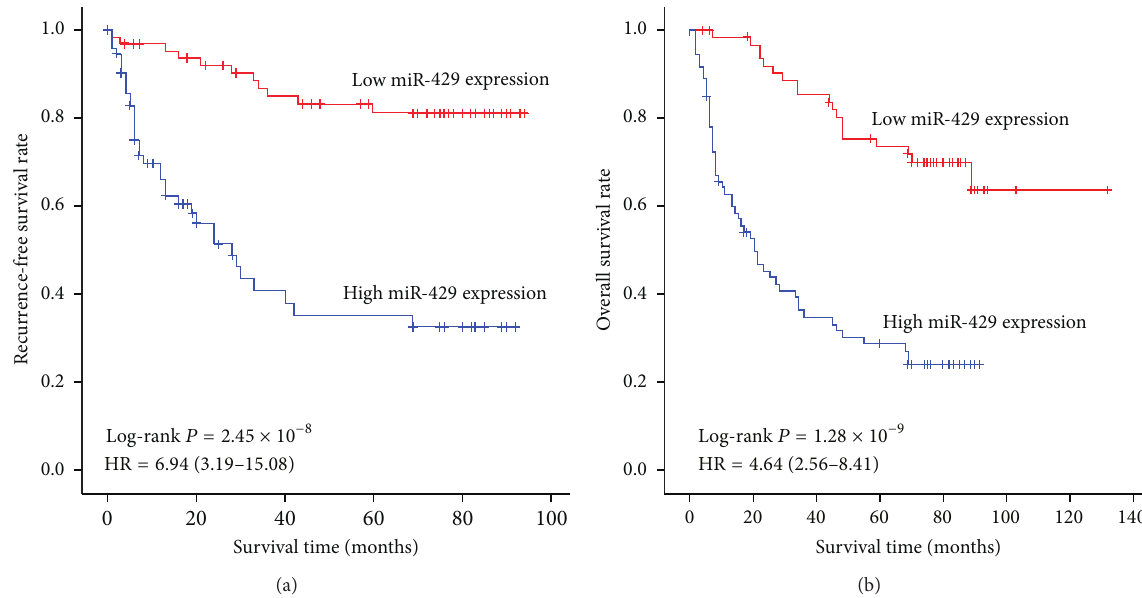
Figure 2: Association between survival and miR-429 expression in 138 HCC cases receiving curative treatment. According to the average expressionincanceroustissues,miR-429expressionwasdividedintotwogroups:lowexpressiongroup(relativelevel ≤ 2)andhighexpression group (relative level > 2). MiR-429 expression was associated with tumor reoccurrence-free survival (a) and overall survival (b) of HCC. Cumulative hazard function was plotted by Kaplan-Meier’s methodology, and 𝑃 value was calculated with two-sided log-rank tests. Relative hazard ratio (HR) and corresponding 95% CIof high miR-429 expression (compared with low expression) were calculated using multivariable cox regression model (including all significant